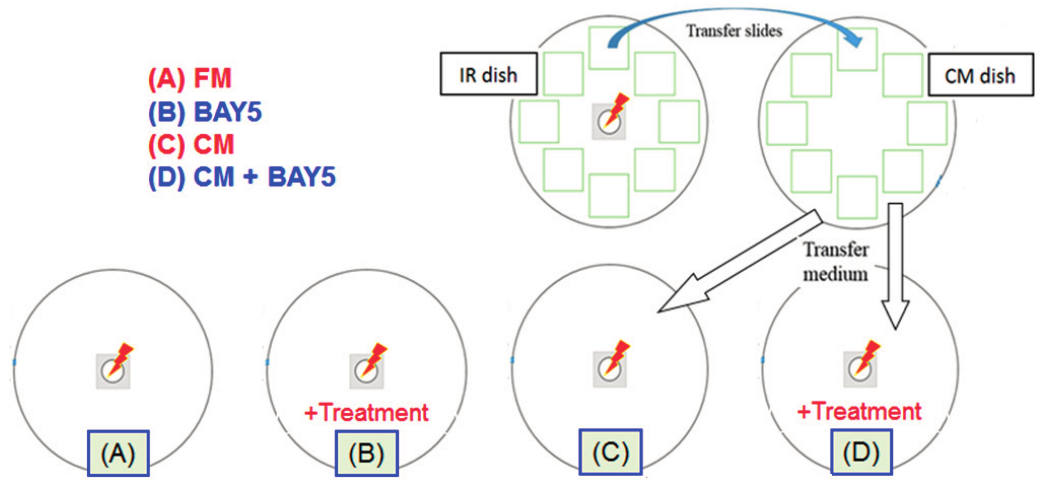
Figure 6. Experimental setup and procedures for the “conditioned medium” approach